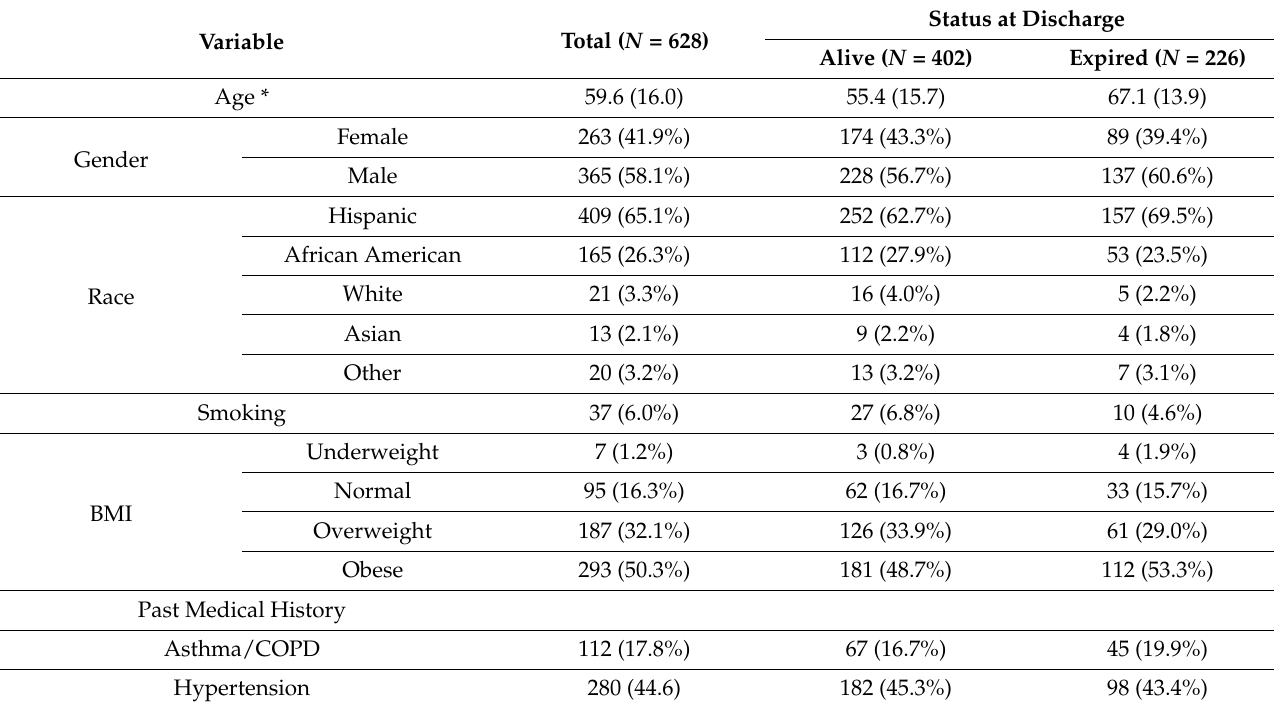
Table 1. Descriptive statistics of the variables included in the